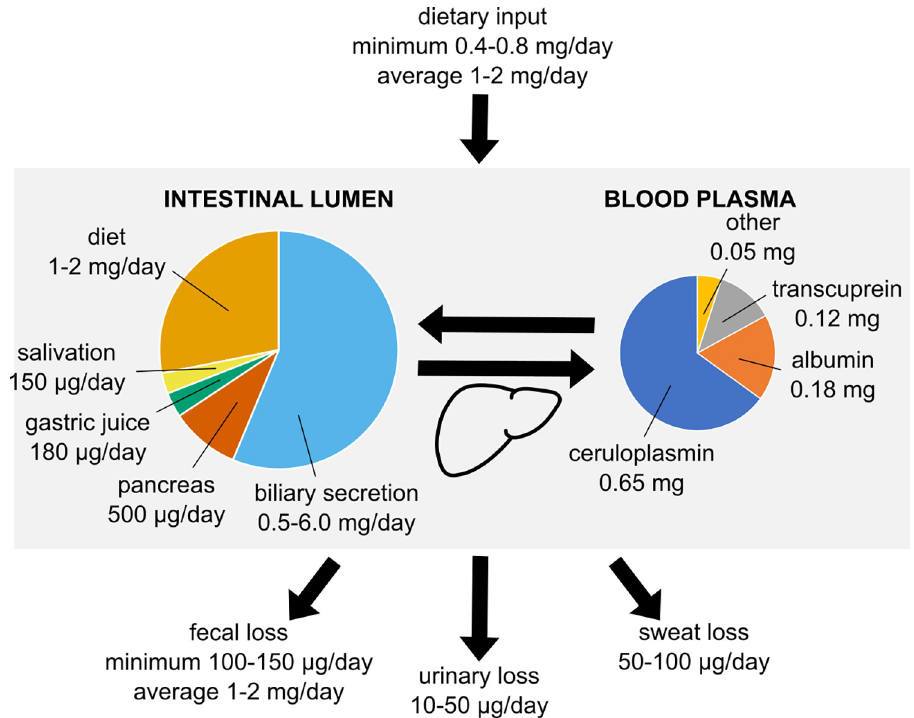
Fig 1. Copper homeostasis in the human body. Under copper homeostatic conditions, the amount of copper that enters an adult human body is the same that leaves the body. Because an average diet provides more copper than the minimum amount required (top), most dietary copper is excreted through feces (bottom). Importantly, most of the copper in the gastrointestinal tract is of endogenous origin (left) so that copper homeostasis is primarily maintained by balancing secretion and reabsorption, rather than through the diet. Circulating copper (right) is mostly bound to ceruloplasmin, and only 5% of circulating copper is not bound to carrier macromolecules. The majority of the copper secreted into the digestive tract (through bile) or into the bloodstream (through ceruloplasmin) comes from the liver, which is the primary organ regulating copper homeostasis.